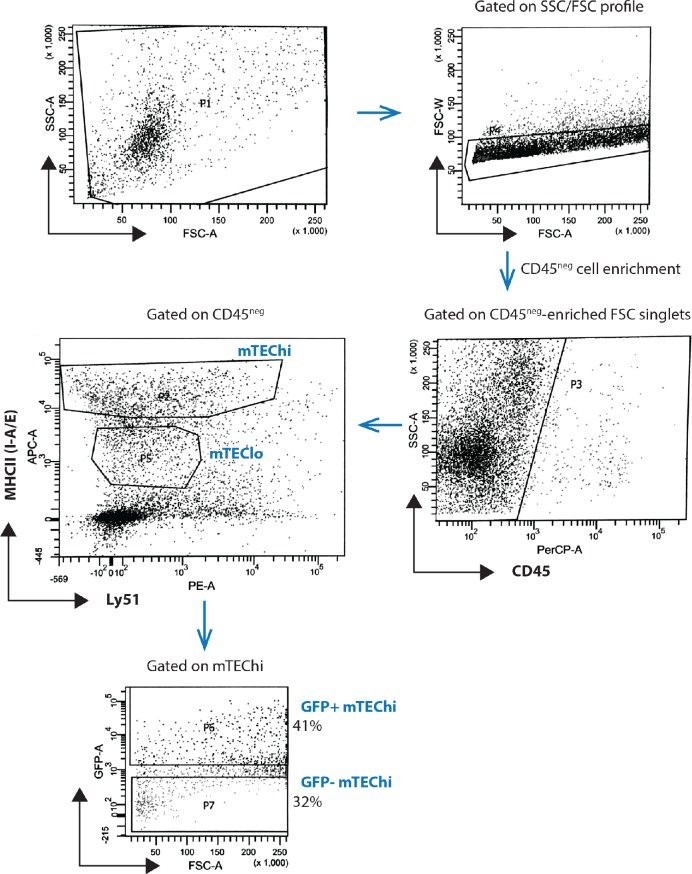
Gating strategy used to purify GFP+ (Clp1 knockdown) and GFP- (Ctr) mTEChi cells.CD45neg thymic cells were separated based on the expression of MHCII (I-A/E) and Ly51. High levels of MHCII and low/intermediate levels of Ly51 marked mTEChi. mTEClo were shown on the figure as cells with low/intermediate levels of MHCII and low levels of Ly51. mTEClo were not sorted out in this experiment. mTEChi were divided into GFP+ and GFP- mTEChi based on the expression of GFP as a marker of Clp1 knockdown activity.